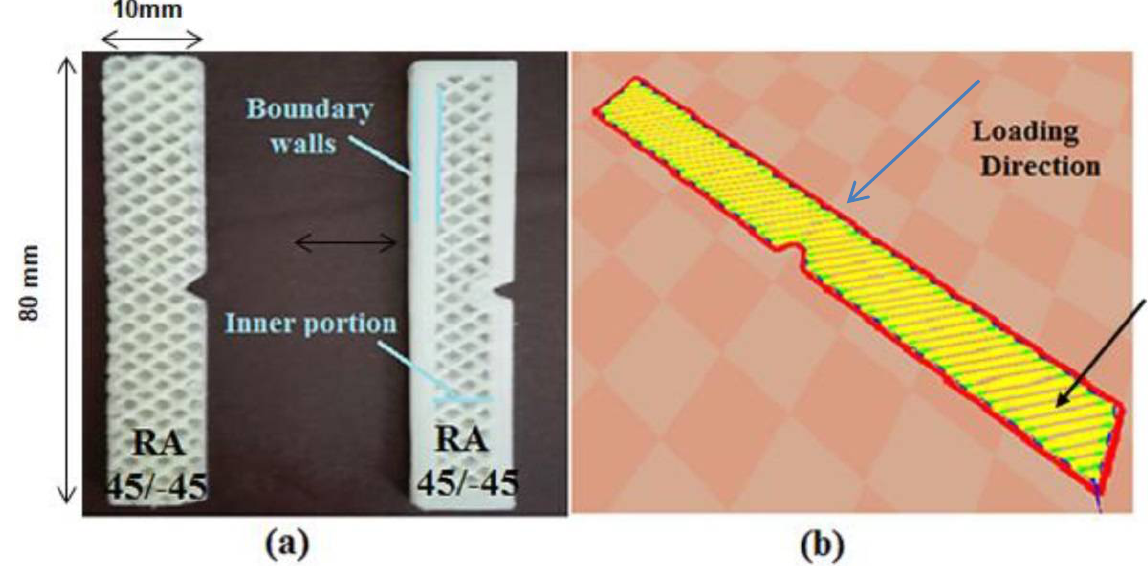
Figure 3. ( a ) Impact sample without and with boundary wall ( b ) Loading direction perpendicular to boundary